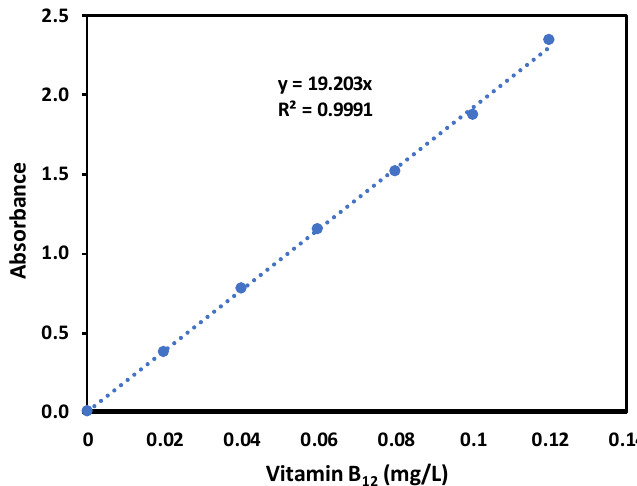
Figure 3. Calibration curve for vitamin B 12 concentration in the continuous W 2 phase.